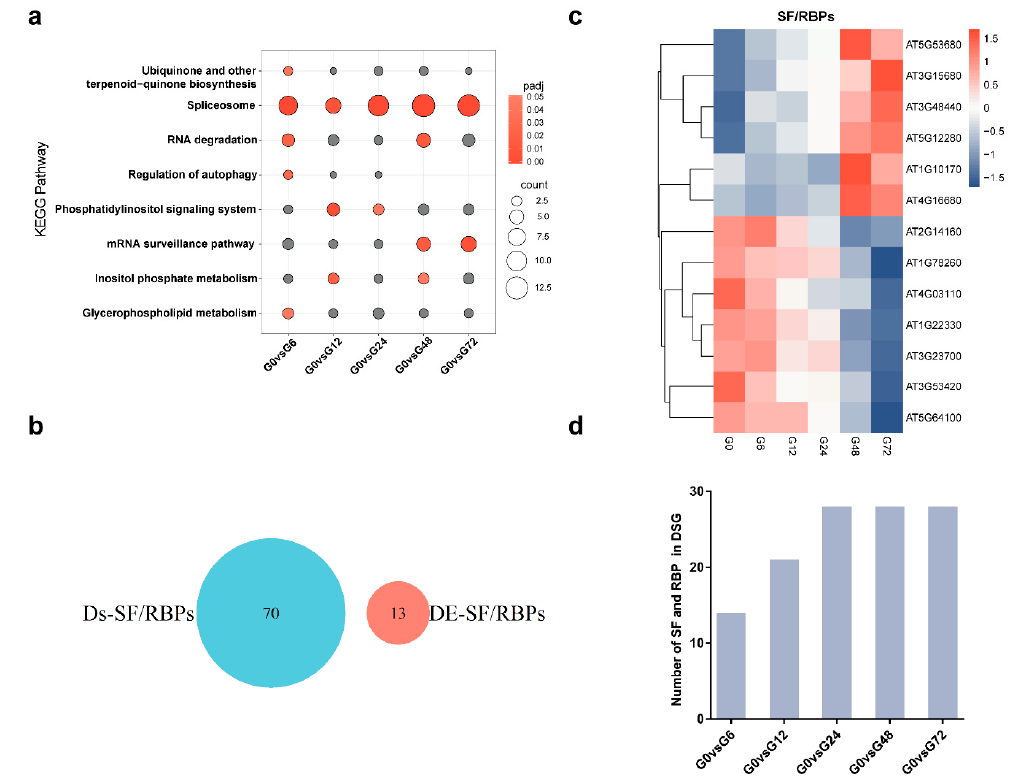
Figure 4. Analysis of di ff erentially alternative splicing and di ff erential expression splicing factor / RNA binding protein (SF / RBP) genes in response to R. solanacearum infection. ( a ) KEGG pathway enrichment for DSG at the indicated time points revealed that the “spliceosome” pathway was the most enriched. The colors of the bubbles indicate the enrichment significance. Gray represents padj > 0.05, while red represents padj < 0.05. The number of enriched genes is indicated by the scale of the bubbles. ( b ) Range comparison for di ff erentially spliced SF-RBPs genes (DS-SF / RBPs) and di ff erentially expression SF / RBPs genes (DE-SF / RBPs). ( c ) Clustering analysis of DE-SF / RBP expression patterns in chronological order. ( d ) Number of DS-SF / RBPs in Arabidopsis roots infected with R. solanacearum in the time